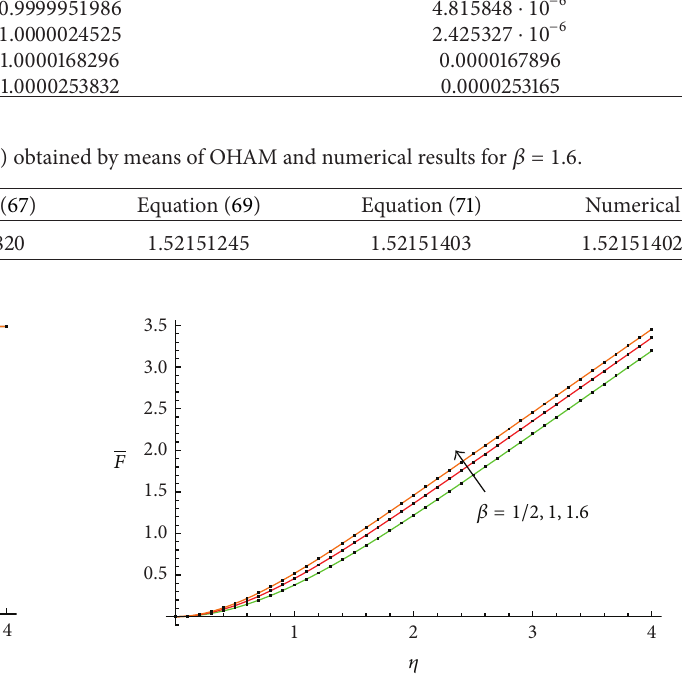
Figure 2: Comparison between the velocity profile obtained from (49), (57), and (65) and numerical results for 𝛽 = 1/2 , 1, and 1.6, respectively: —numerical; ... OHAM solution.